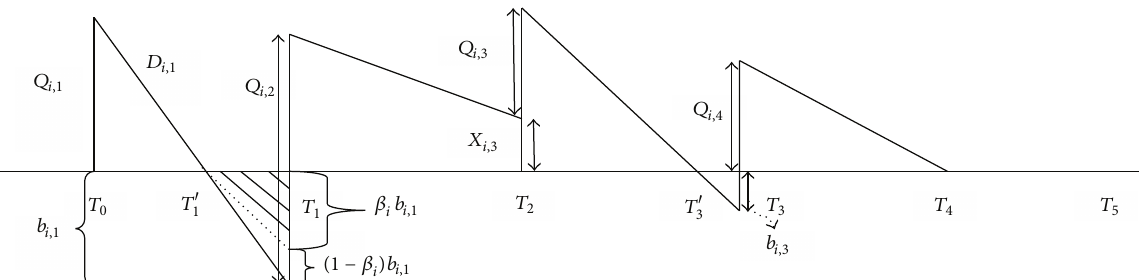
Figure 1: Some possible situations for the inventory of item 𝑖 in 5